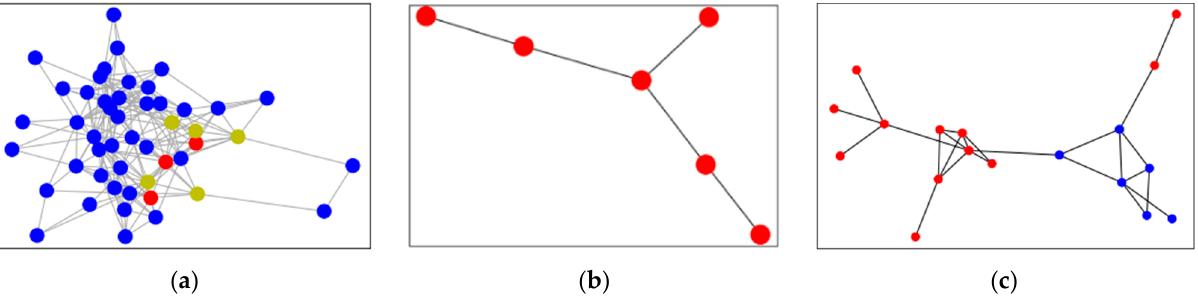
Figure 6. Analysis on card groups, ( a ) card association network; ( b ) discovering new group; ( c ) expansion of merchants. Table 5. Comparison of three clustering algorithms.